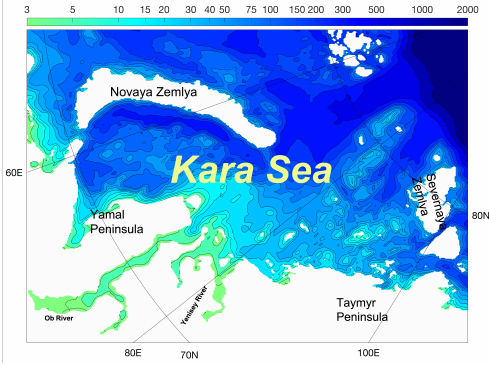
Figure 1. Model domain and its